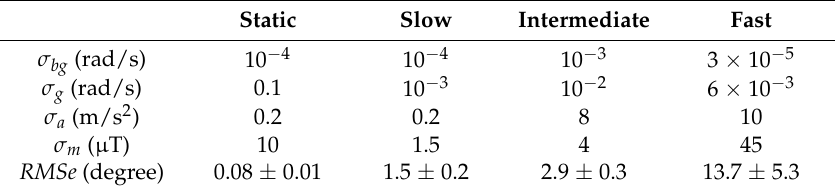
Table 3. Identified Kalman parameters and corresponding RMSe .